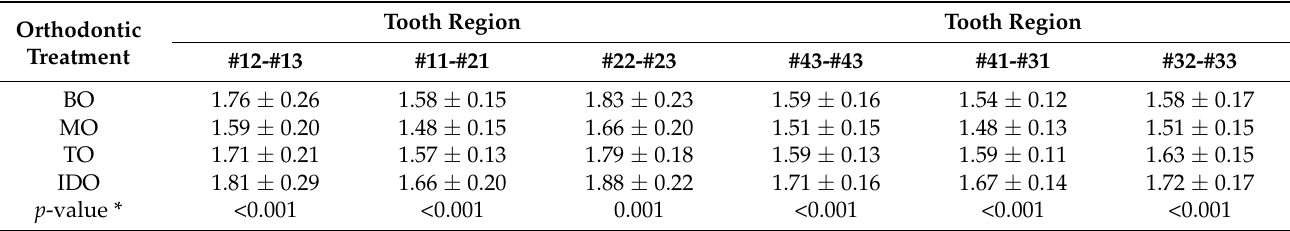
Table 4. R/G ratio of papillary gingivitis in the